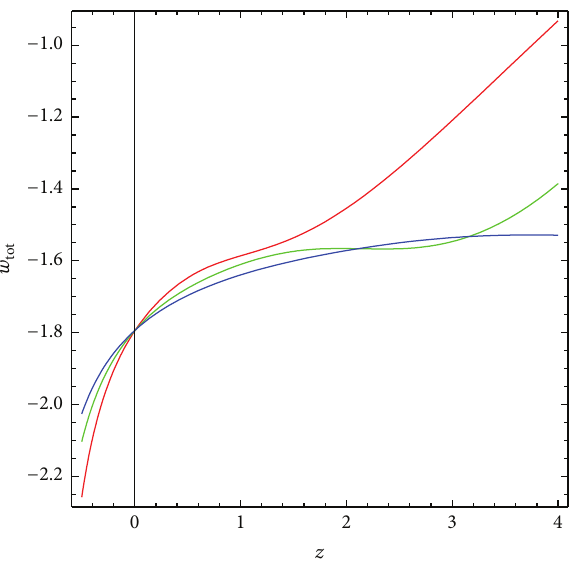
Figure 14: Plot of 𝑤